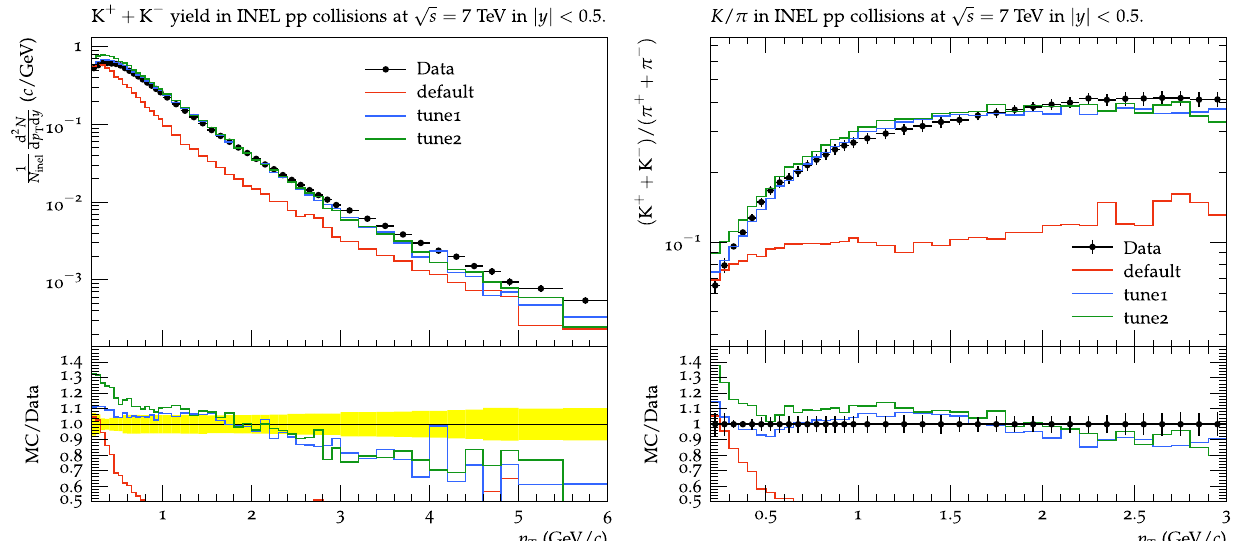
√ s = 7TeV in the central rapidity region. We